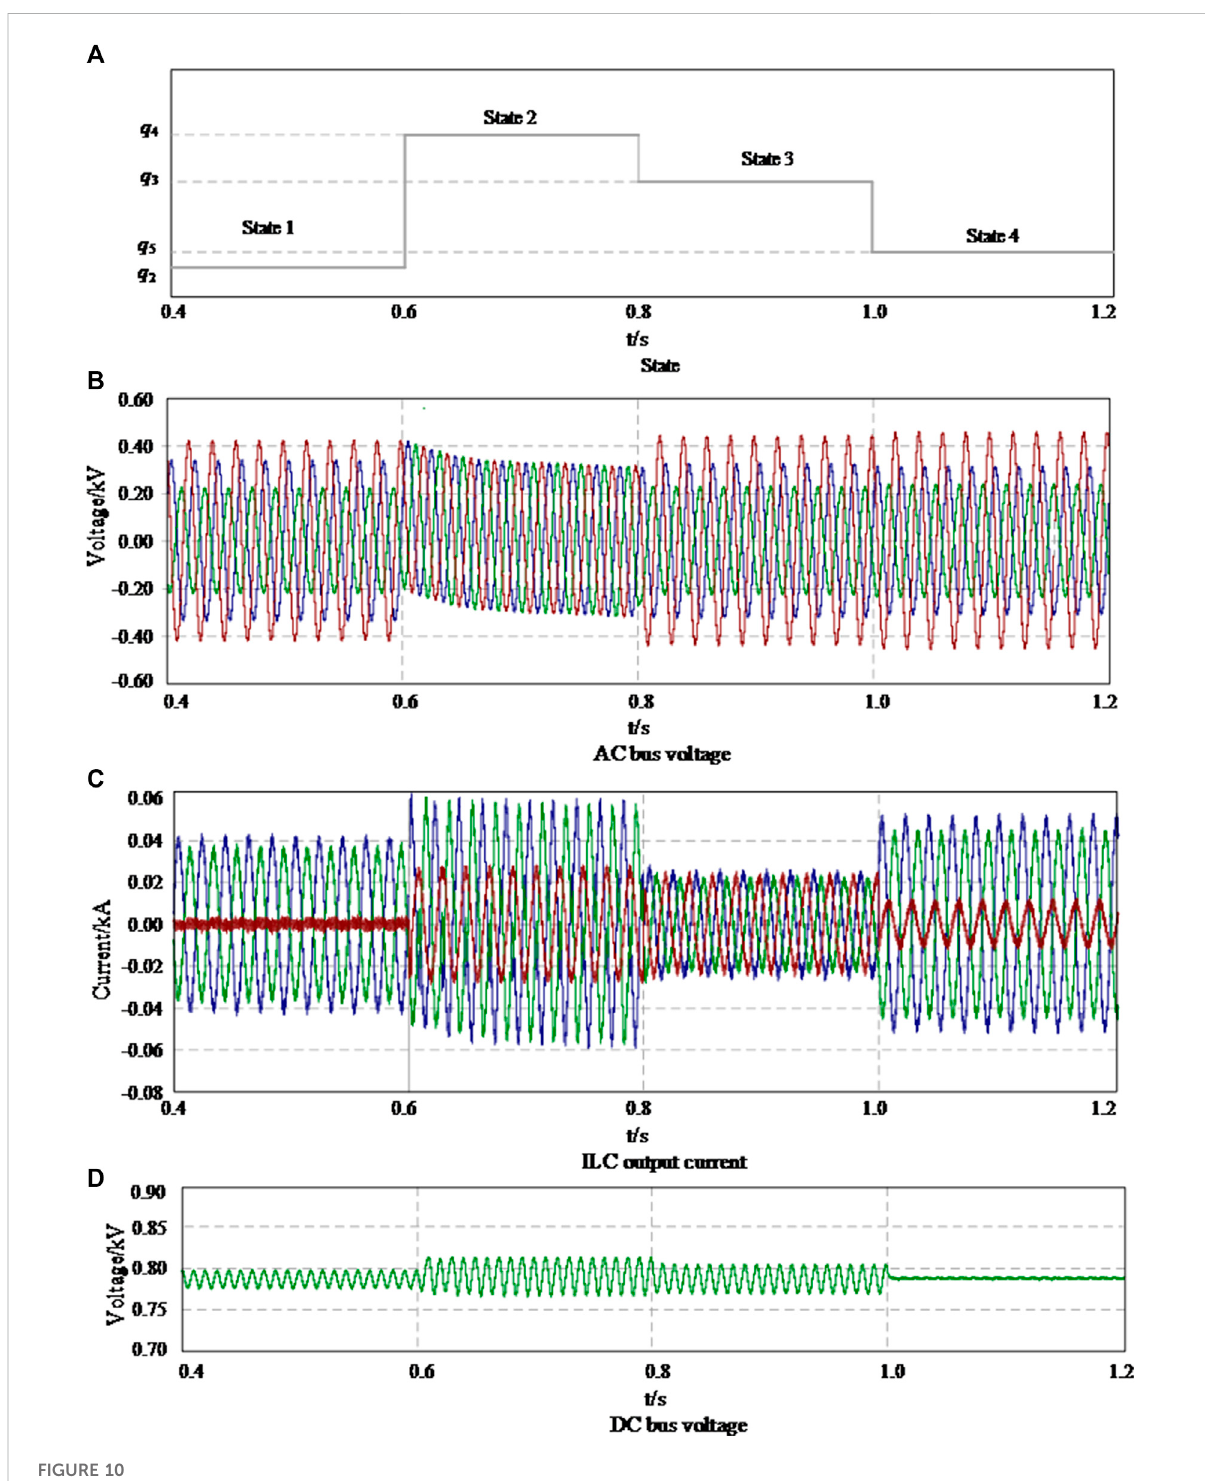
FIGURE 10 The conversion process of different operating states of